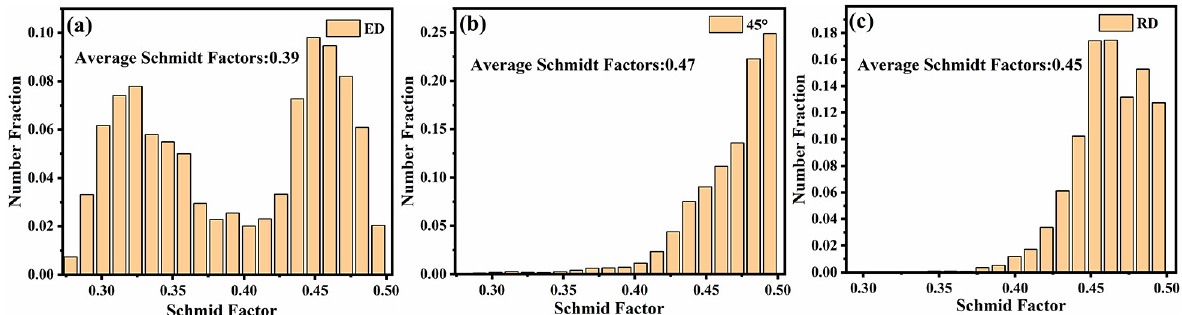
Figure 5. Schmid factor of sliding system {111} <110> for different specimens: ( a ) ED ( b ) 45°, and ( c ) RD.